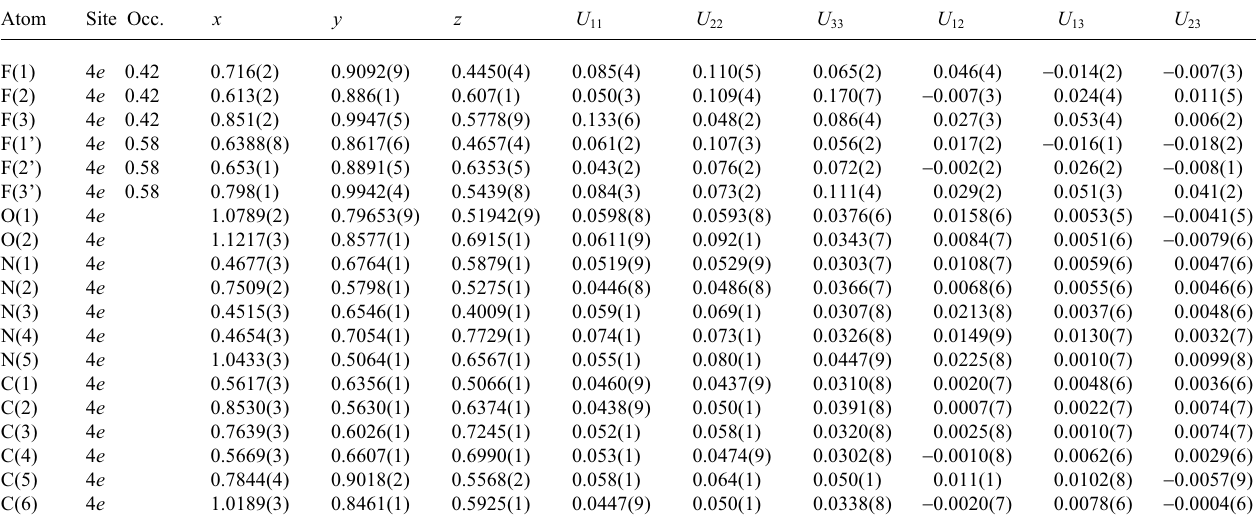
Table 3. Atomic coordinates and displacement parameters (in Å 2 )